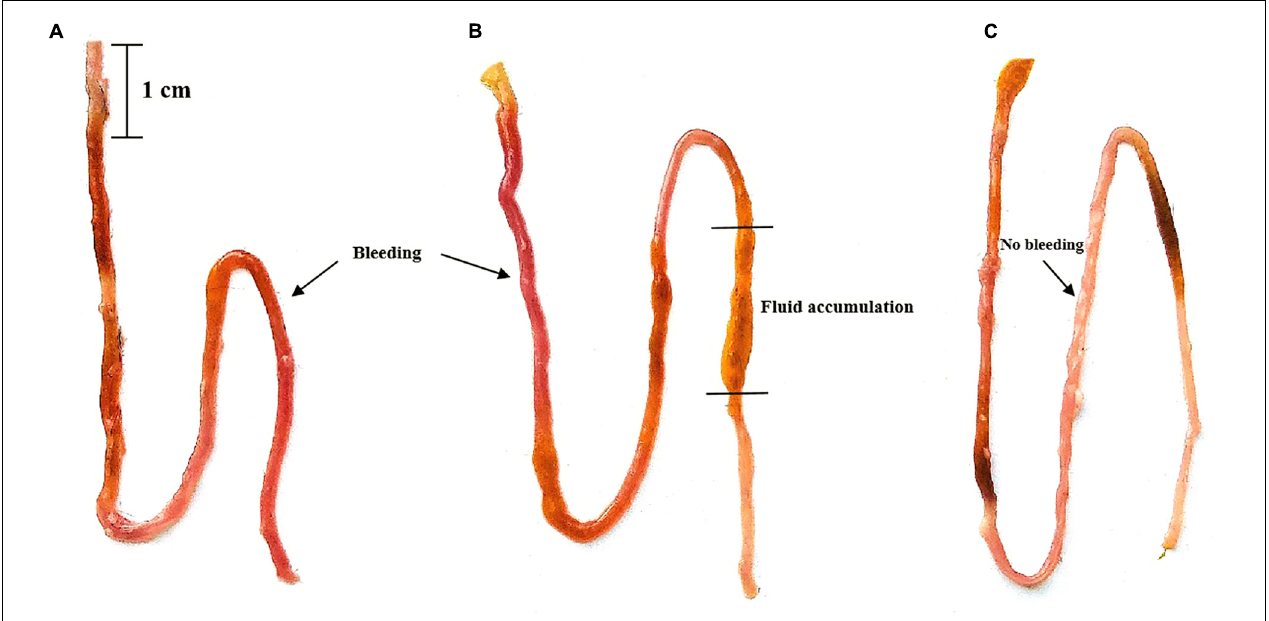
FIGURE 1 | Effects of oral gavage with Vibrio parahaemolyticus (Vp) on the ileum of pseudo germ-free and normal (SPF) mice. (A) Pseudo germ-free mouse, (B) SPF mouse, (C) control mouse. The control mice were given fresh sterilized LB medium instead of Vp.